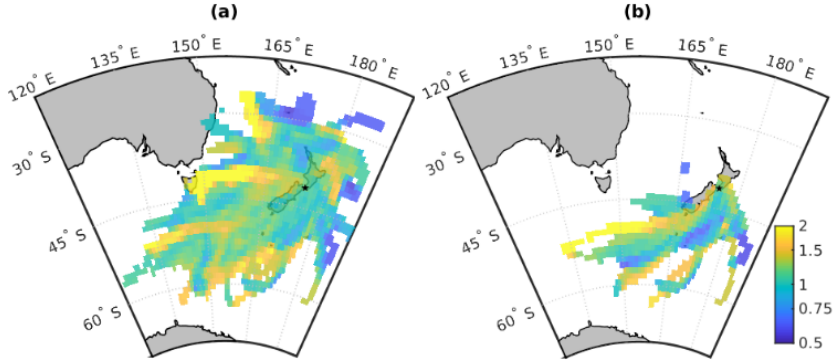
Figure 10. Source regions of 2–4nm ions for all data (a) and only marine data (b) .